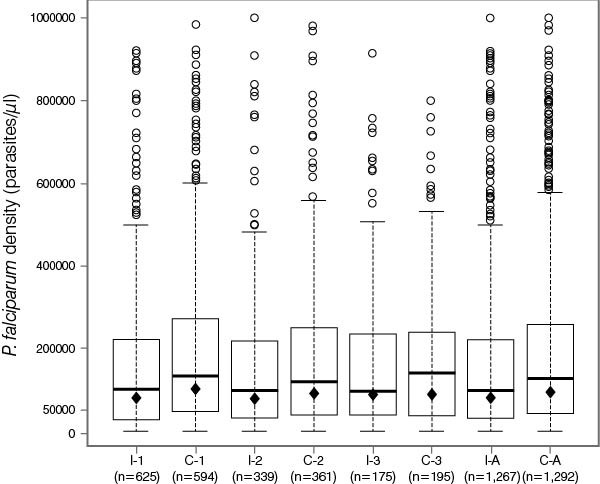
Distribution of P. falciparum density during SMRC5000 in infants and children <5 years of age following screening campaign 3. I = intervention arm; C = control arm; numbers 1–3 indicate first, second and third episodes, and A any episode; n = number of subjects at each episode; central rectangles span the first quartile to the third quartile (IQR); the line inside each rectangle shows the median; the whiskers that extend from each box indicate the range of values that are outside of the intra-quartile range but close enough not to be considered outliers (a distance less than or equal to 1.5*IQR); ♦ = geometric mean.